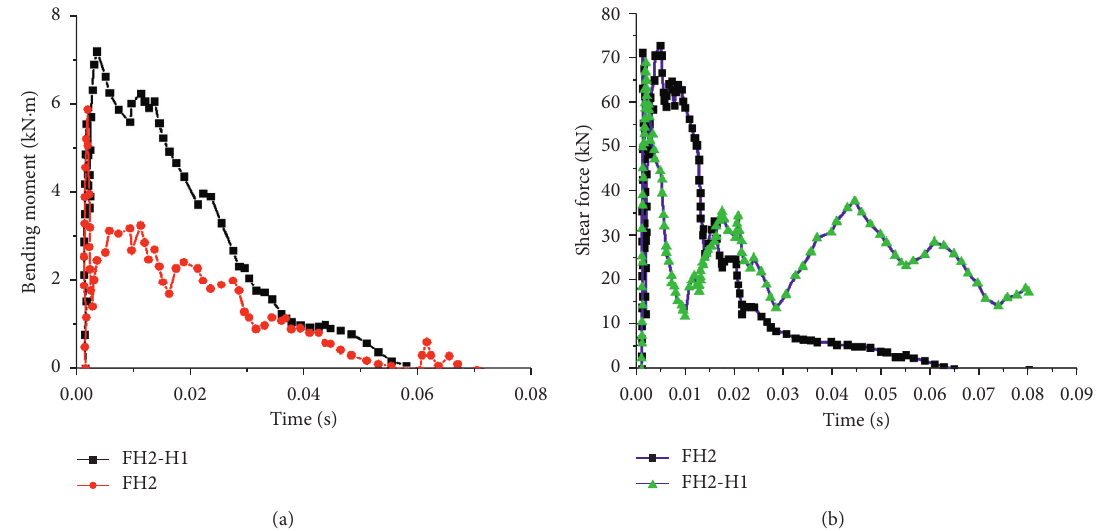
Figure 10: Time-history curve of the bending moment for the impact point section. (a) Bending moment time history curve. (b) Shear time history curve.